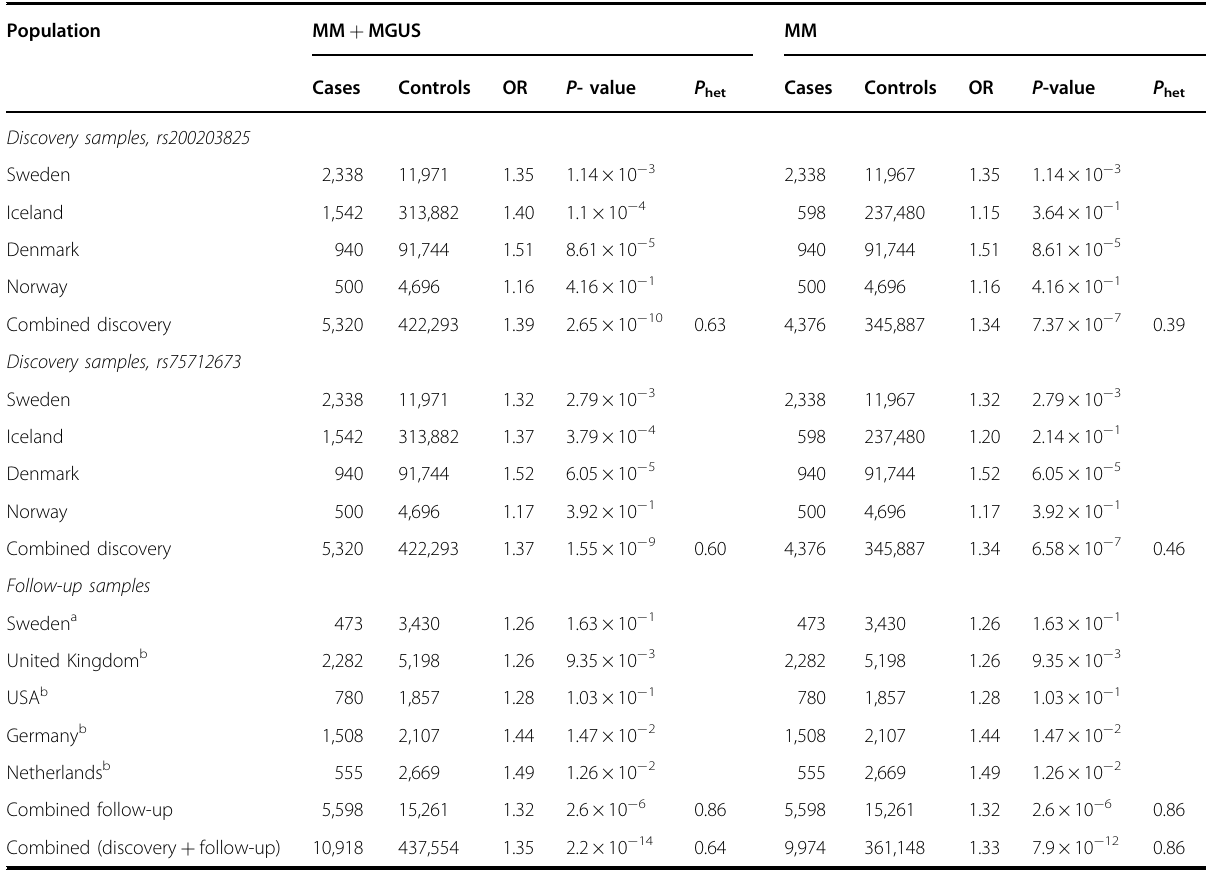
Table 1 Association data for the 13q13 association signal. Population